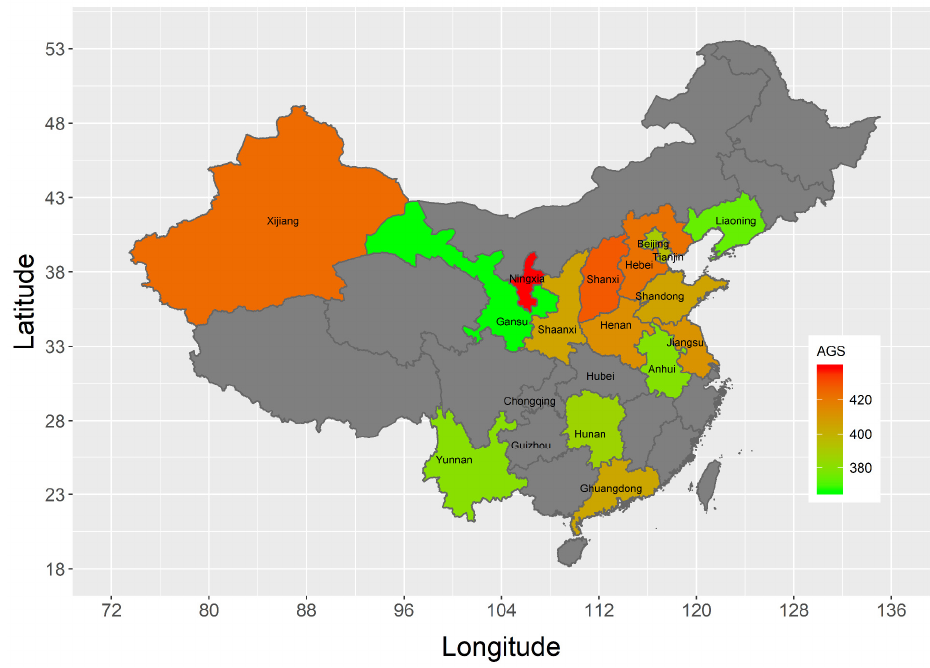
Figure 4. A map illustrating the average genome sizes of Chinese jujube cultivars in different provinces of China. AGS: Average genome size (Mb), indicated by the colors shown.